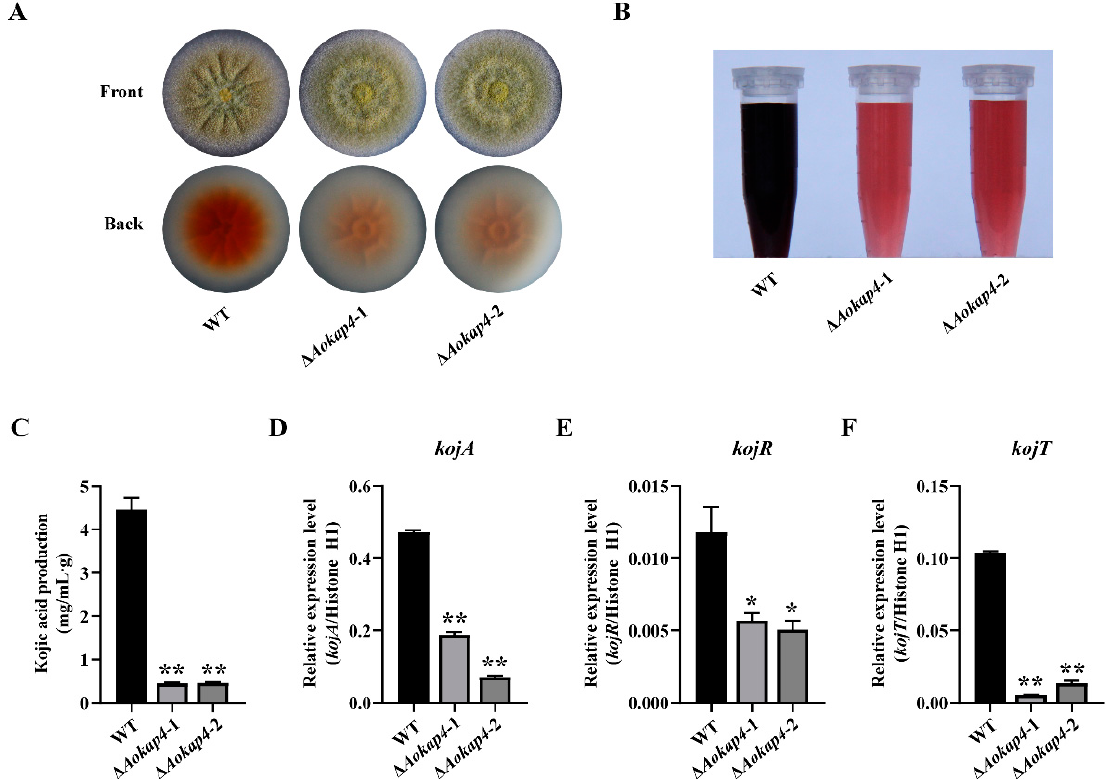
Figure 4. AoKap4 affected kojic acid production in A. oryzae . ( A ) Colony growth of the wild-type and Aokap4- deletion strains cultured on the CD plates with 1 mM FeCl 3 for four days. Kojic acids chelated with FeCl 3 showing a visible red. ( B ) Color reaction of kojic acid produced by the wild-type and Aokap4- deletion strains inoculated in the modified CD liquid medium for seven days at 200 rpm and 30 °C. ( C ) The yield of kojic acid in the wild-type and Aokap4- deletion strains cultivated in the modified CD liquid medium for seven days at 30 °C. ( D – F ) Transcript levels of kojA ( D ), kojR ( E ) and kojT ( F ) in the wild-type and Aokap4- deletion strains. The mycelia from the wild-type and Aokap4- deletion strains cultured in the modified CD liquid medium were harvested to extract total RNA. The gene-expression levels were detected via qPCR. All assays were performed in triplicate. Asterisks indicate statistical significance in the differences between the WT and Aokap4- deletion strains based on Student’s t -tests (** p < 0.01, * p < 0.05).